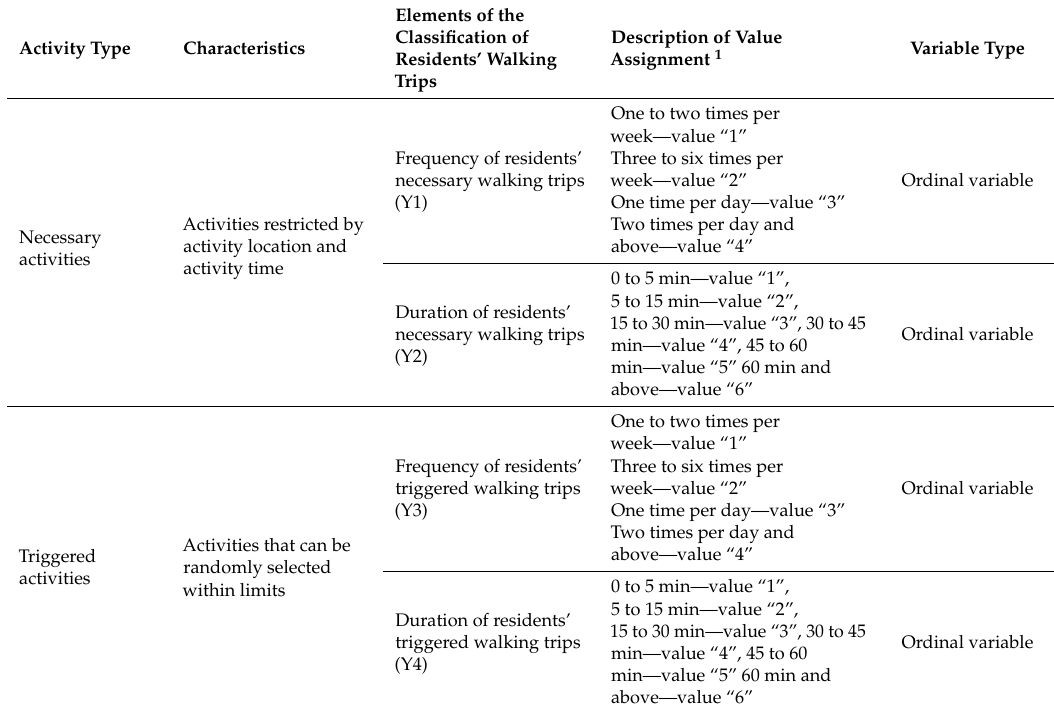
Table 4. Classification of di ff erent elements on residents’ walking